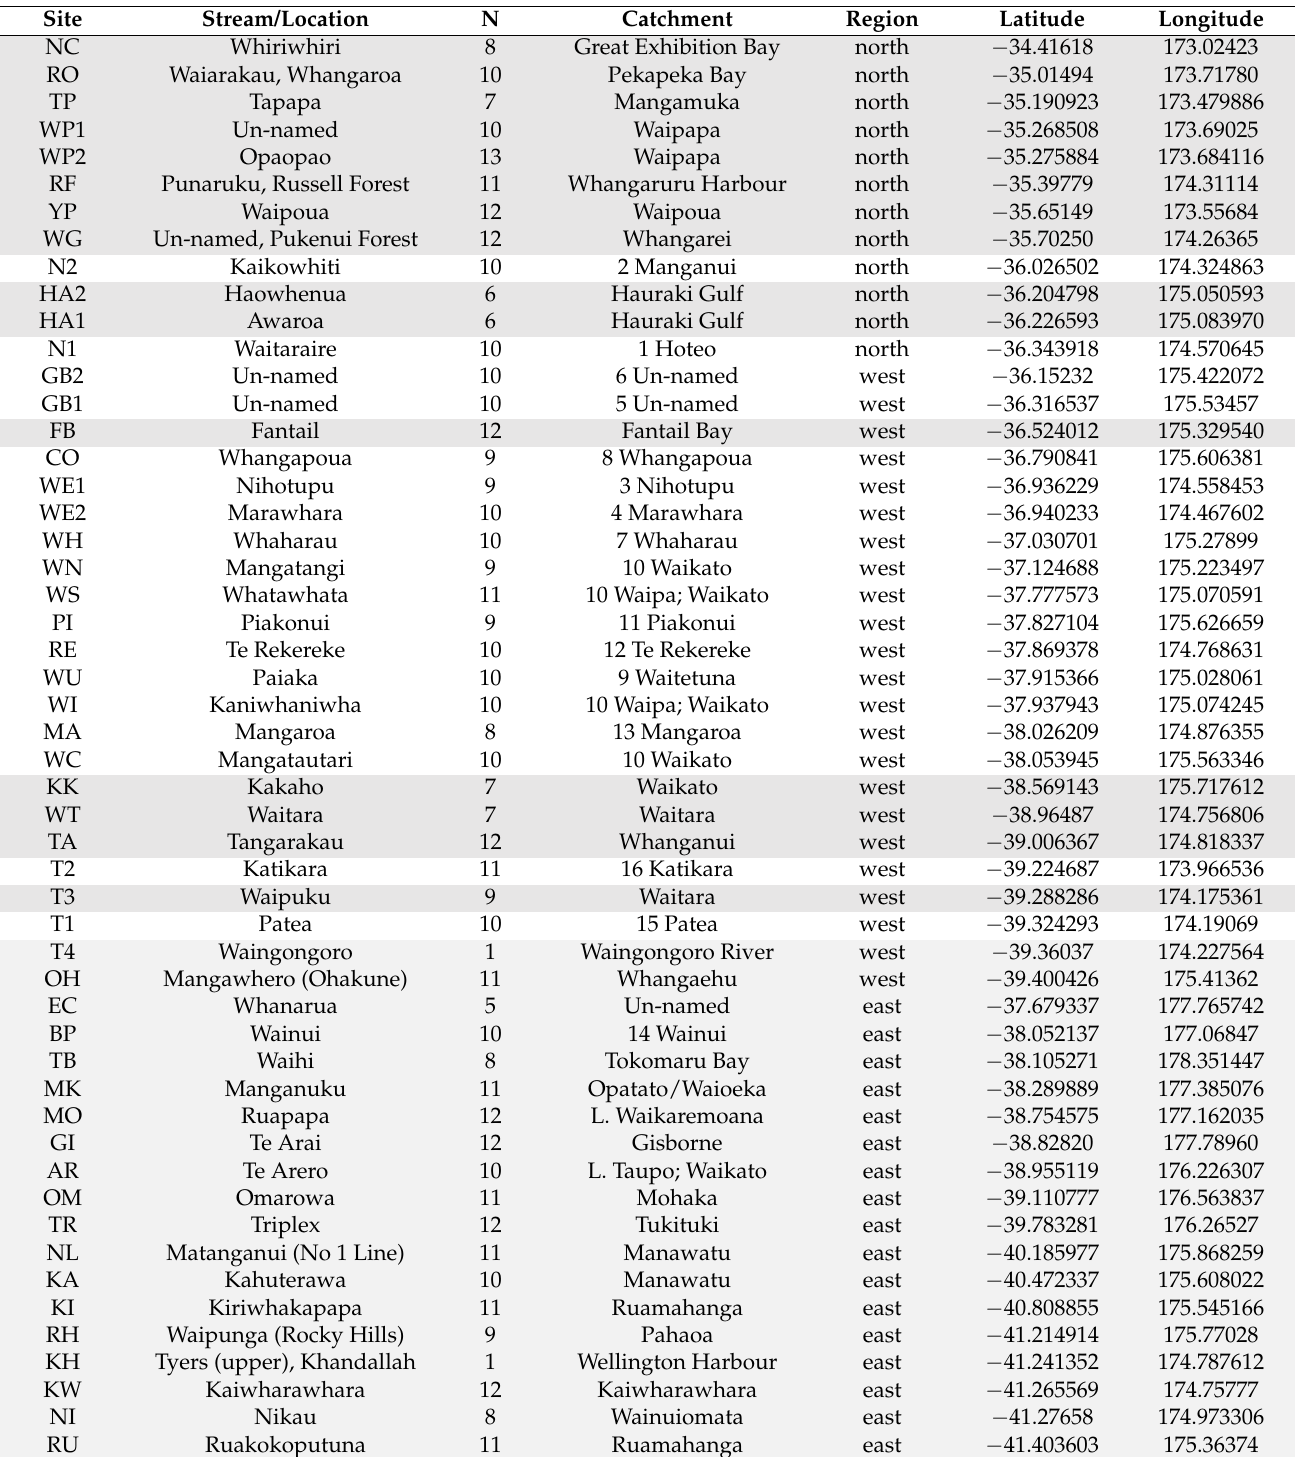
Table 1. Sampling of Acanthophlebia cruentata in North Island, New Zealand ordered by latitude. Shaded entries relate to population samples reported here, and others are as given by Smith et al., (2006) [25]. N is the number of individuals sequenced from that location. Latitudes and longitudes are in decimal degrees from the New Zealand Geodetic Datum 2000 system. Region is the inferred grouping of population